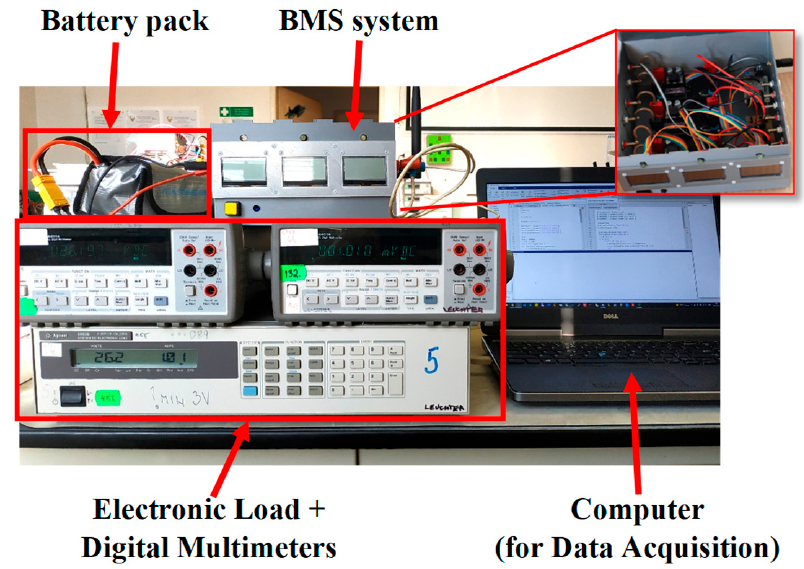
Figure 15. Experiment setup for measurement of current and voltage.